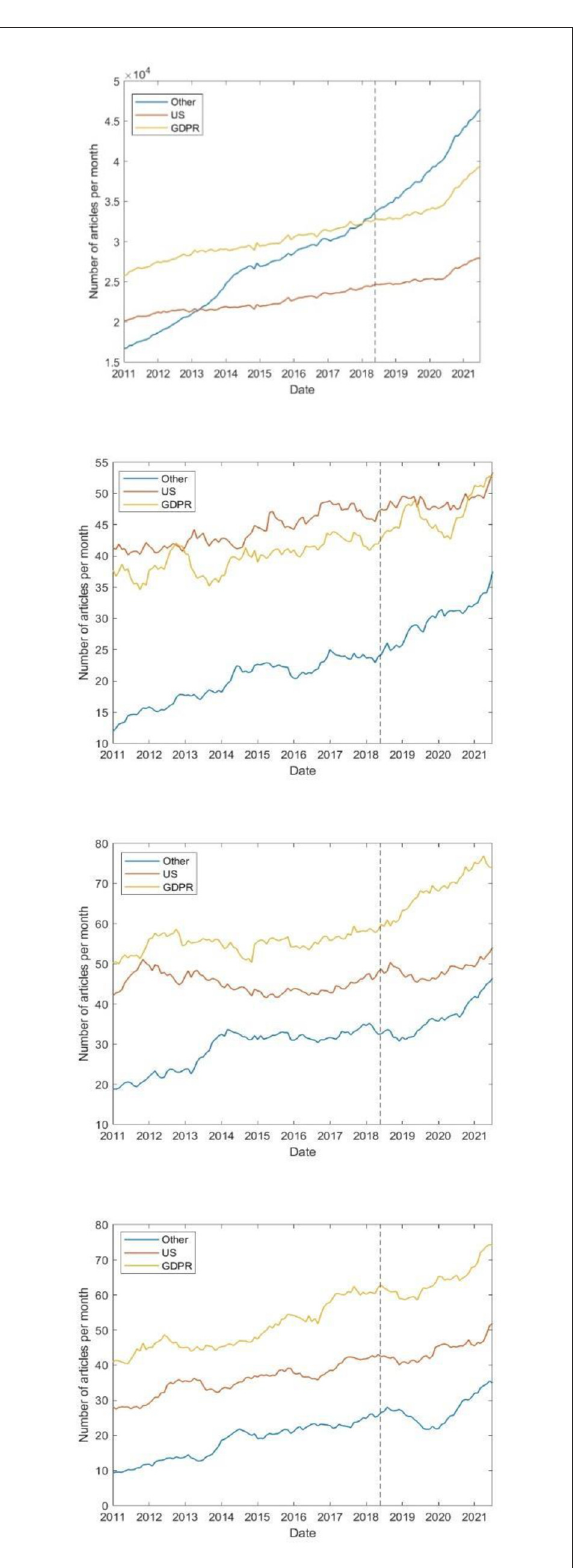
FIGURE5 Number of papers published over time, excluding those related to COVID-19. From top to bottom: Total, phase 1, 2, and 3. The vertical dotted line denotes the date of